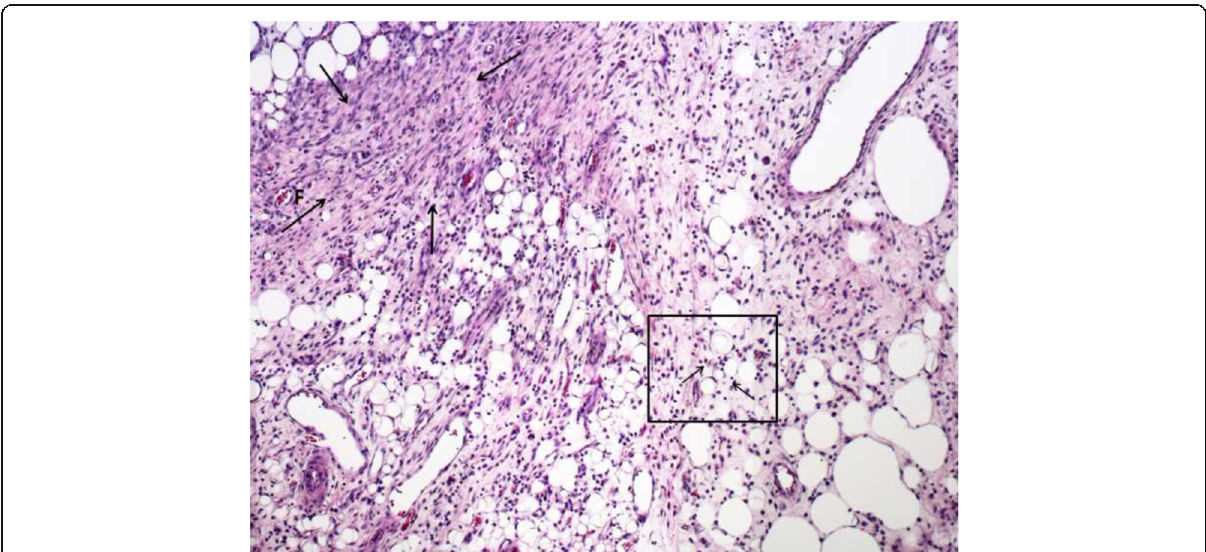
Fig. 4 Histology image of the healed wound with moderate interstitial lymphocytic infiltration ( small arrows in the box) and dermal fibrosis (group PHH)